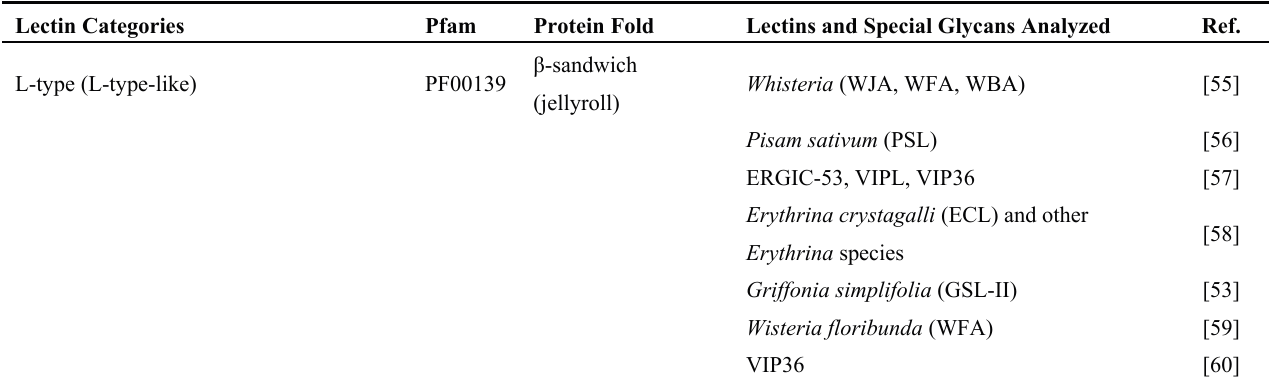
Table 1. Summary of lectins, for which comprehensive quantitative analyses by FAC-FD have been